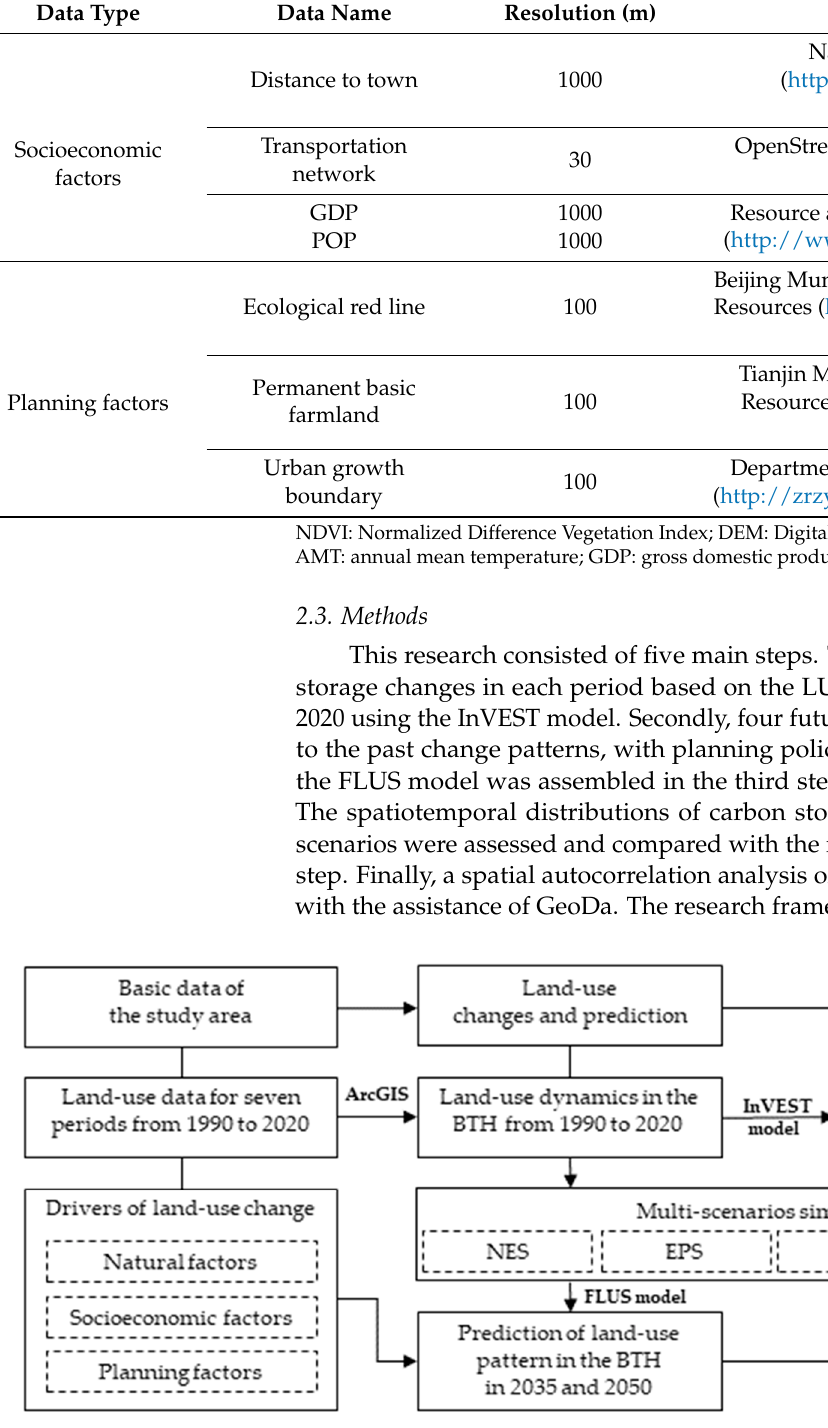
Table 1. The land-use drivers and data sources.